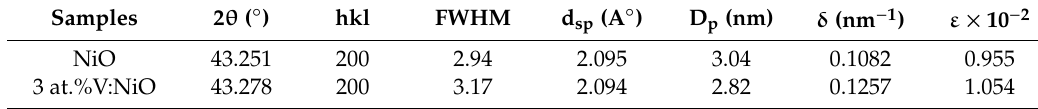
Figure 1. ( a ) XRD spectra of pristine and 3 at.%V:NiO nanoparticles (NPs) and ( b ) enlarged XRD spectra of pristine NiO and 3 at.%V:NiO NPs. Table 1. Measured values of structural parameters for NiO and V:NiO.